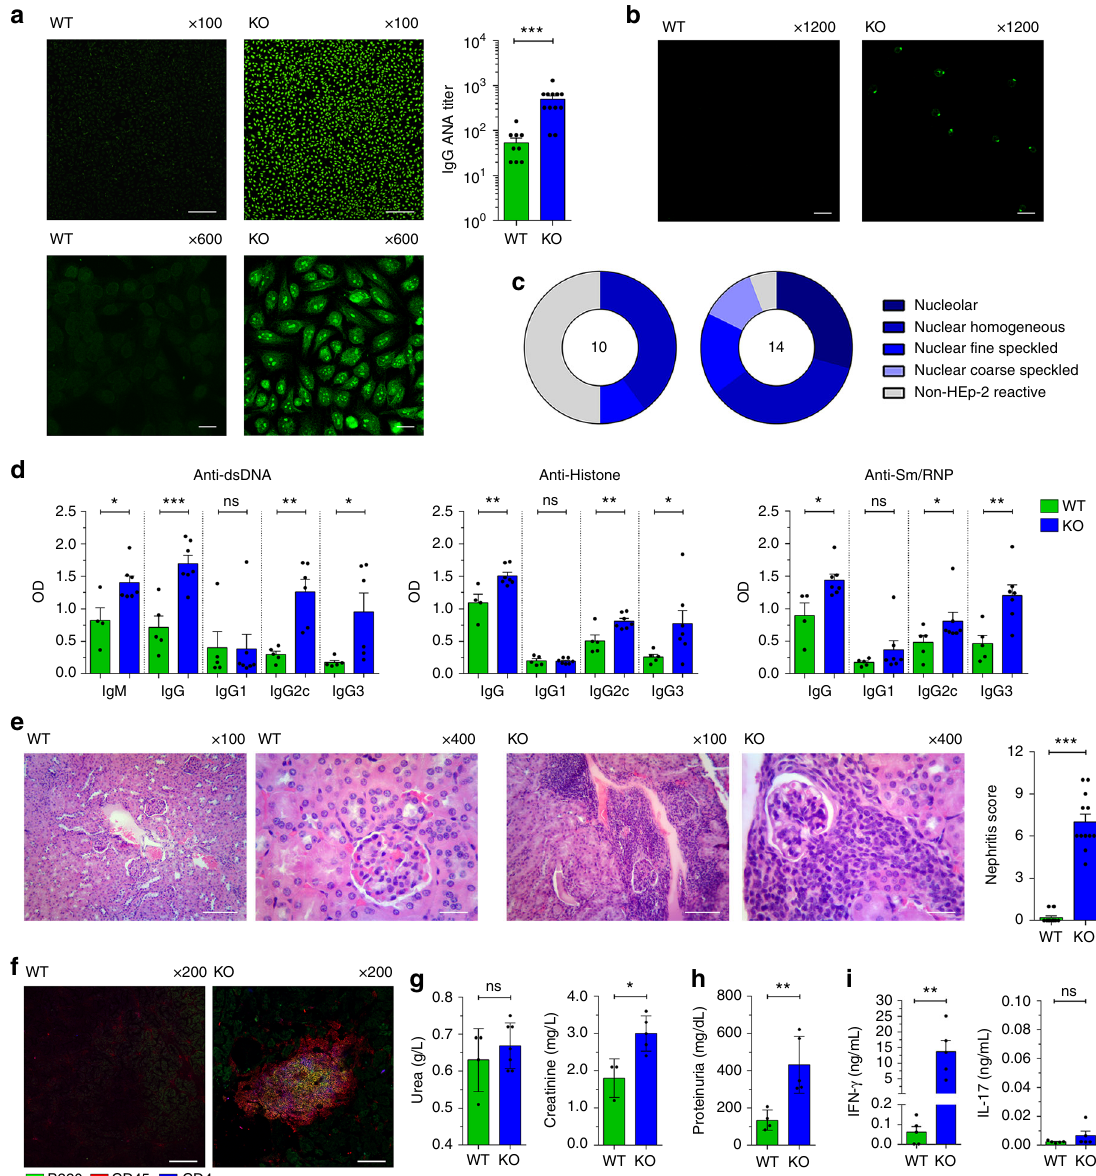
Fig. 5 Aged Gal-3 KO mice presented signs of autoimmunity. a ANA IgG titres determined using Hep-2 slides in sera from 8-month-old WT and Gal-3 KO mice. Magni fi cation: ×100 (top) and ×600 (bottom) (WT n = 9; Gal-3 KO n = 13). Scale bar, 200 μ m (upper panels) and 20 μ m (lower panels). b dsDNA IgG determined using Crithidia luciliae slides. Magni fi cation: ×1200 (WT n = 9; Gal-3 KO n = 13). Scale bar, 10 μ m. c Pie charts summarizing the distribution of serum samples exhibiting the different Hep-2 patterns: Nucleolar; nuclear homogeneous; nuclear fi ne speckled; nuclear coarse speckled; and non-HEp-2 Reactive. The numbers in the centers of the graphs denote the number of samples analysed per group. Animals with ANA titres higher than 1/40 were scored as positive (WT n = 9; Gal-3 KO n = 13). d IgM, IgG1, IgG2c, and IgG3 autoantibodies levels speci fi c for dsDNA, histone and Sm/RNP determined by ELISA (WT n = 5; Gal-3 KO n = 7). e Kidney sections stained with H&E (left) and the nephritis score (right). Magni fi cation: ×100 and ×400 (WT n = 10; Gal-3 KO n = 12). Scale bar (from left to right), 100, 20, 100, and 20 μ m. f Immuno fl uorescence of kidney sections stained with anti-B220 (green), anti- CD45 (red) and anti-CD4 (blue). Magni fi cation: ×200 ( n = 4 for both strains). Scale bar, 100 μ m. g , h Urea (left) and creatinine (right) concentrations in sera ( g ) and protein levels in 24-h urine samples ( h ) from 8-month-old WT and Gal-3 KO mice (WT n = 4; Gal-3 KO n = 7). i IFN- γ and IL-17 concentrations in sera from 8-month-old WT and Gal-3 KO mice ( n = 5 for both strains). Data are the mean ± s.e.m. * p < 0.05, ** p < 0.005, *** p < 0.001. ns not signi fi cant (unpaired Student ’ s t -test). All experiments were performed in 8-month-old WT (green) and Gal-3 KO (blue) mice. a , c , e Data are representative of four independent experiments. b , d Data are representative of two independent experiments. f – i Data are representative of